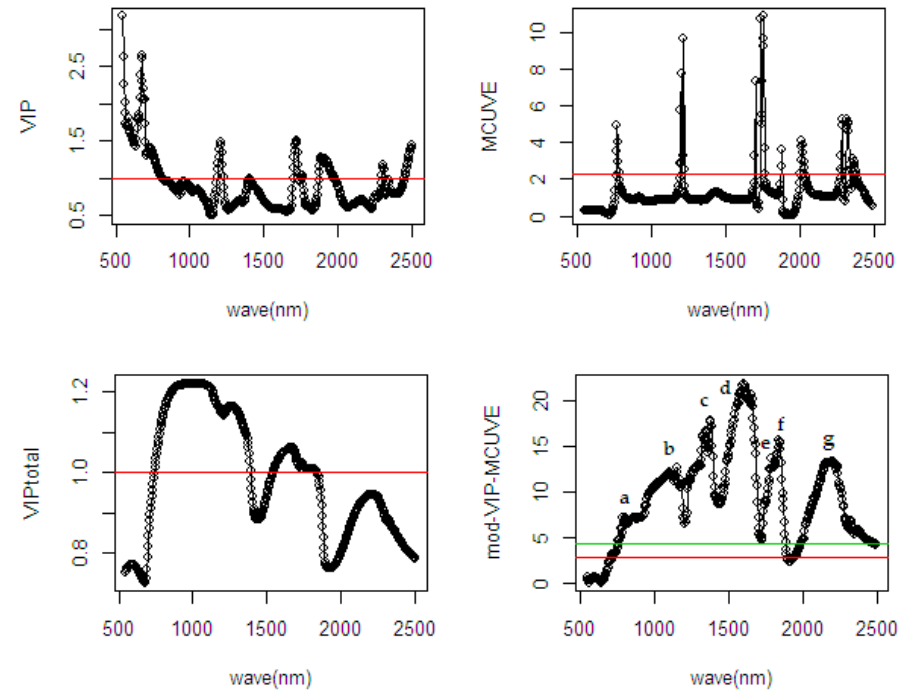
Figure 8. Comparison of selected wavelengths from different wavelength selection methods using spectral data of fresh fruit mesocarp on the %OWM.